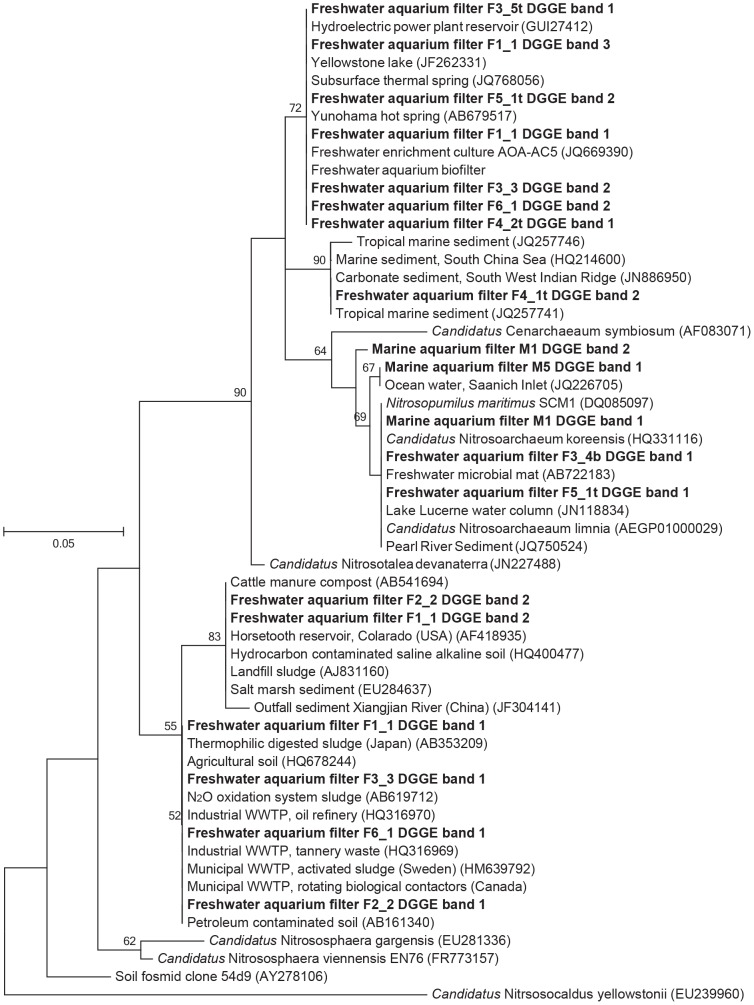
Maximum likelihood phylogenetic tree of thaumarchaeal 16S rRNA gene sequences and DGGE bands based on 500 bootstrap values.Only bootstrap values greater than 50% are indicated. The scale bar represents 5% nucleotide divergence.